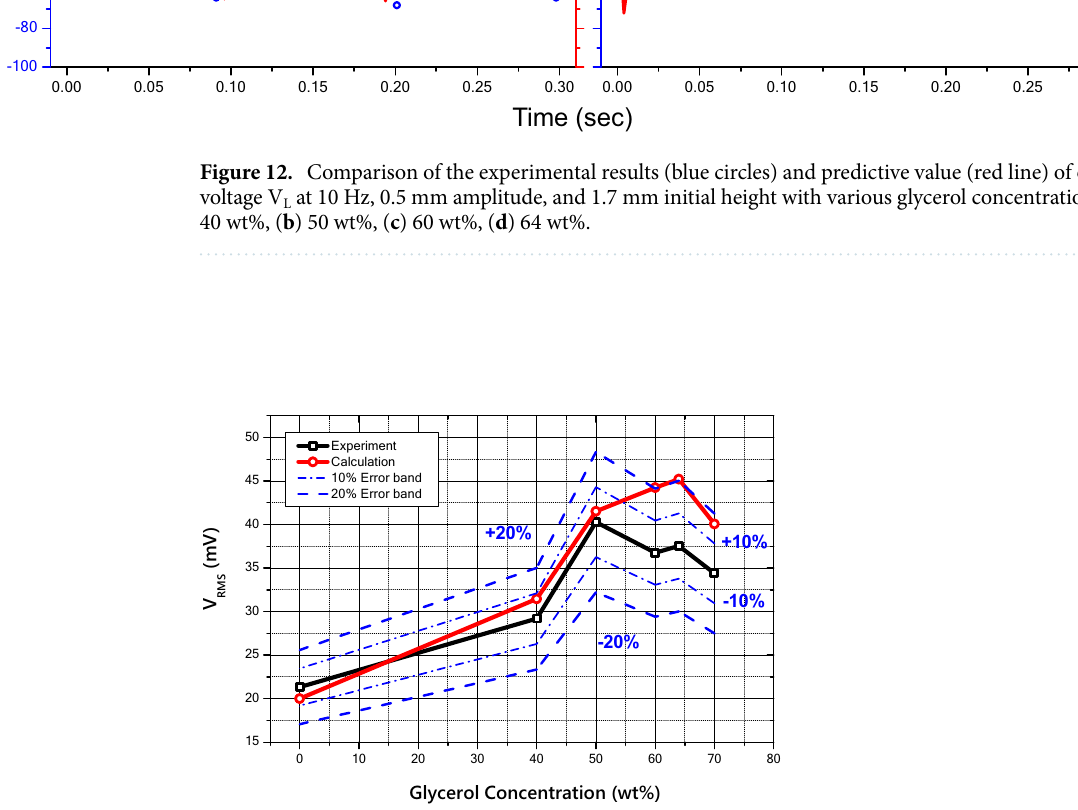
Figure 13. Comparison of RMS output voltage between experimental results and predictive